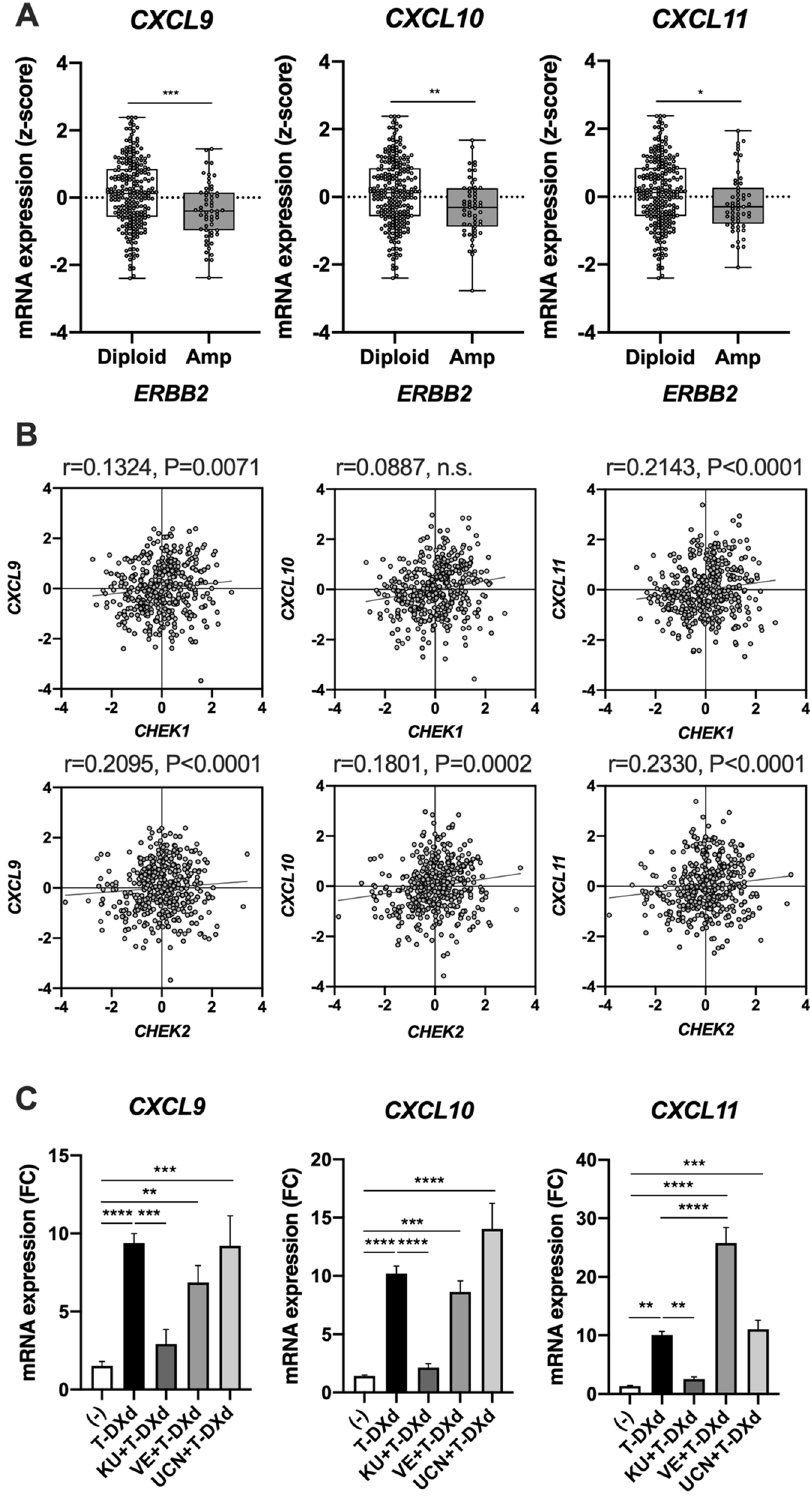
Figure 4. Involvement of DNA damage signaling in the induction of mRNA expression of CXCL9/10/11 by T-DXd in HER2-positive GC cells. ( A ) Comparison of mRNA expression (z-score) of CXCL9 , CXCL10 , and CXCL11 between ERBB2 amplified GC tissues (Amp) (n = 55) and ERBB2 non-amplified GC tissues (Diploid) (n = 238) from TCGA dataset. ( B ) Correlation among mRNA expression (z-score) of CXCL9 , CXCL10 , CXCL11 , CHEK1 , CHEK2 , and TP53 in samples from 412 patients with GC from TCGA dataset. ( C ) qPCR analysis of CXCL9, CXCL10, and CXCL11 in NCI-N87 cells treated with 1 μg/ml T-DXd in the absence or presence of 10 μM KU-55933 (KU), 10 μM VE-821 (VE), or 100 nM UCN-01 (UCN) for 72 h (n = 3). Values are shown as means ± SEM. * P < 0.05, ** P < 0.01, **** P <